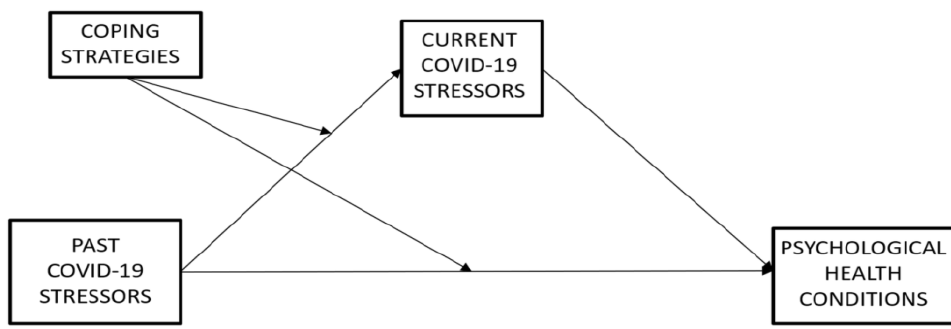
Figure 1. The conceptual mediated ‐ moderated model.